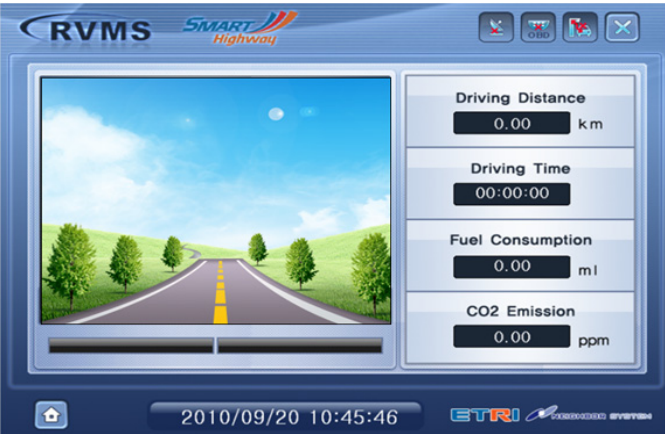
Figure 10. Example of a Telematics device with normal information.